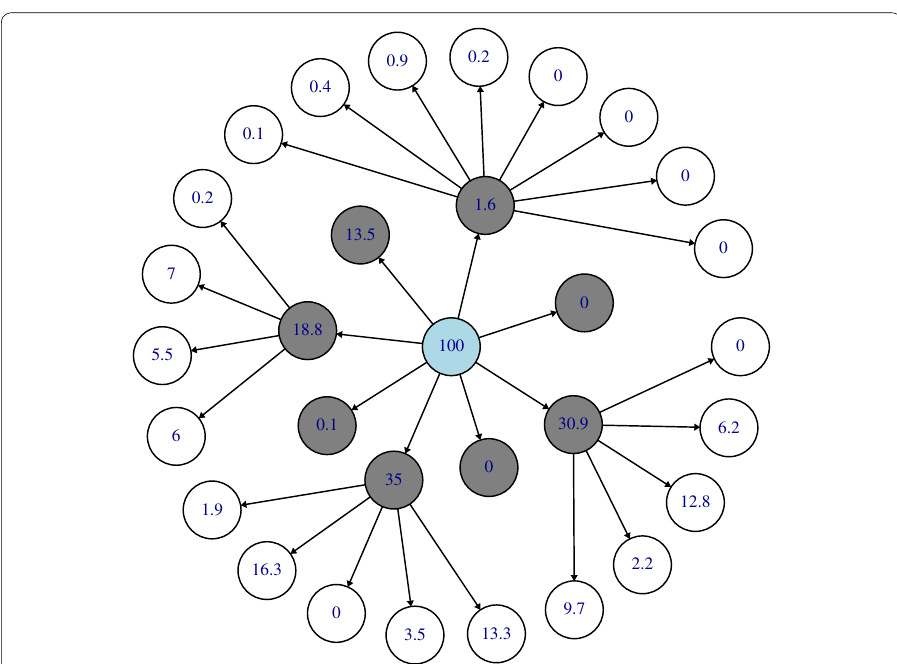
Fig. 9 Tree diagram for the image shown in Fig. 6. The number in each bubble indicates the percentage of pixels contained in the corresponding